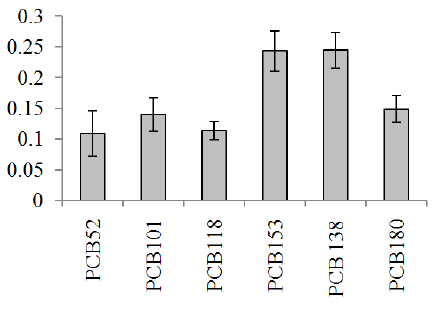
Figure 4. Relative average composition of PCB congeners to ∑ PCBs in the sample#1 to